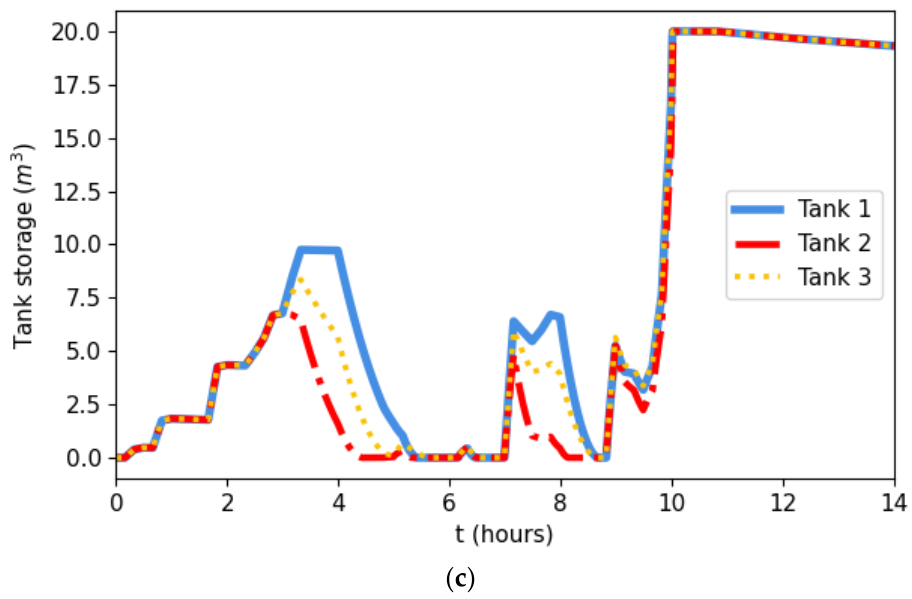
Figure 7. Results of applying the optimization process on a rain event recorded by Beit Dagan meteorological station on 20–21 November 2020. ( a ) Flow pattern of benchmark run (no controlled releases—red) and from applying the optimized controlled release policy (blue). Q objective , which was used to evaluate the policy’s fitness according to Equation (5), is plotted in dashed green. ( b ) The controlled release policy, which was derived by applying the genetic algorithm—the degree of each valve’s opening during the simulated event. ( c ) Water stored in each tank during the simulated event. Table 6. Peak flow reduction and rainwater availability reduction, resulting from applying either the optimized controlled release policy or the alpha release policy on each of the three rain